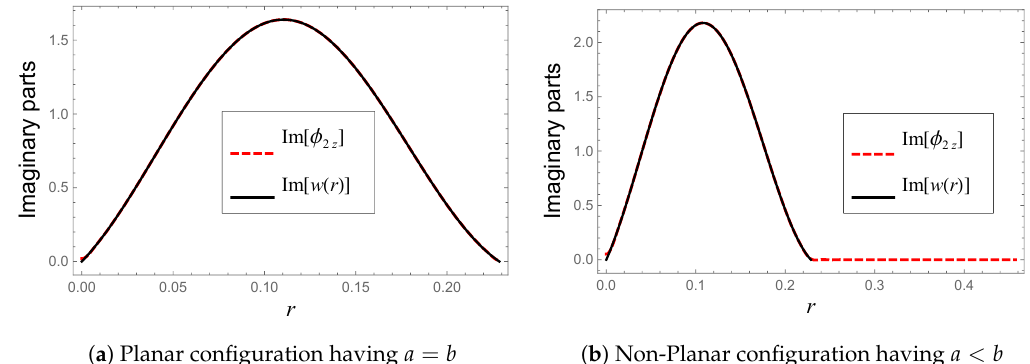
Figure 4. The imaginary parts of normal velocity and membrane displacement at z = 0.